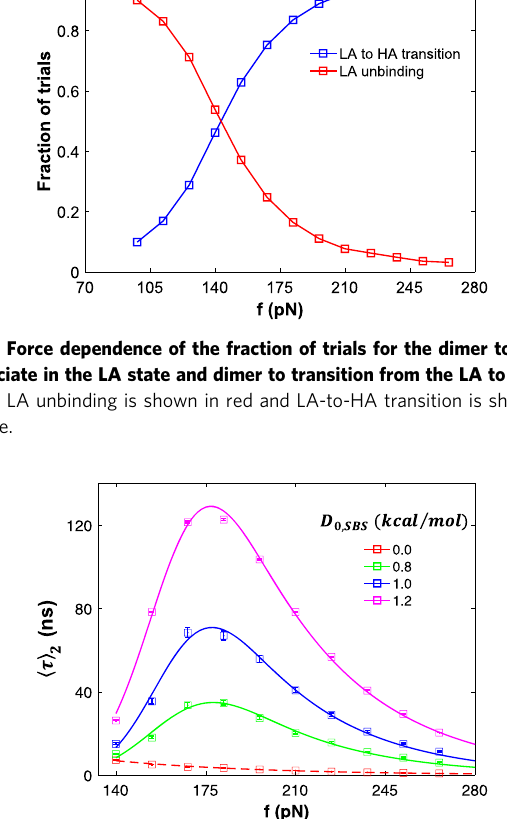
Fig. 3 Effects of secondary interaction energy well depth ( D o,SBS ) on mean lifetime 〈 τ 〉 vs. force f curve of a nanoparticle dimer. Symbols are from MD simulations and the curves are generated using an exponentially modi fi ed Gaussian distribution fi tting function. The error bars represent the 95% con fi dence intervals, derived by the bootstrapping